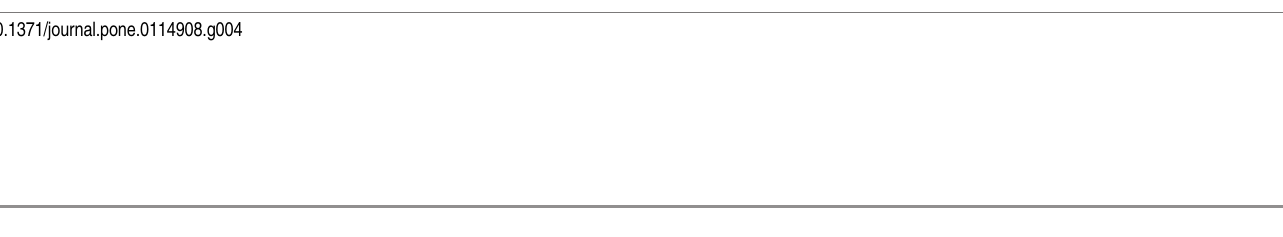
Fig. 4. Effect of THU on smooth muscle cell numbers and percent of area fraction of collagen and elastin content in the aortic media of mice with or without Cd exposure. Panels A, B and C are representative photographs of aortic samples ( 6 250) stained with H&E, picrosirius red and Miller’s elastic stain, respectively. Results are expressed as mean ¡ SEM., n 5 6–8/group. * P , 0.05 compared with normal control group; { P , 0.05 compared with Cd control